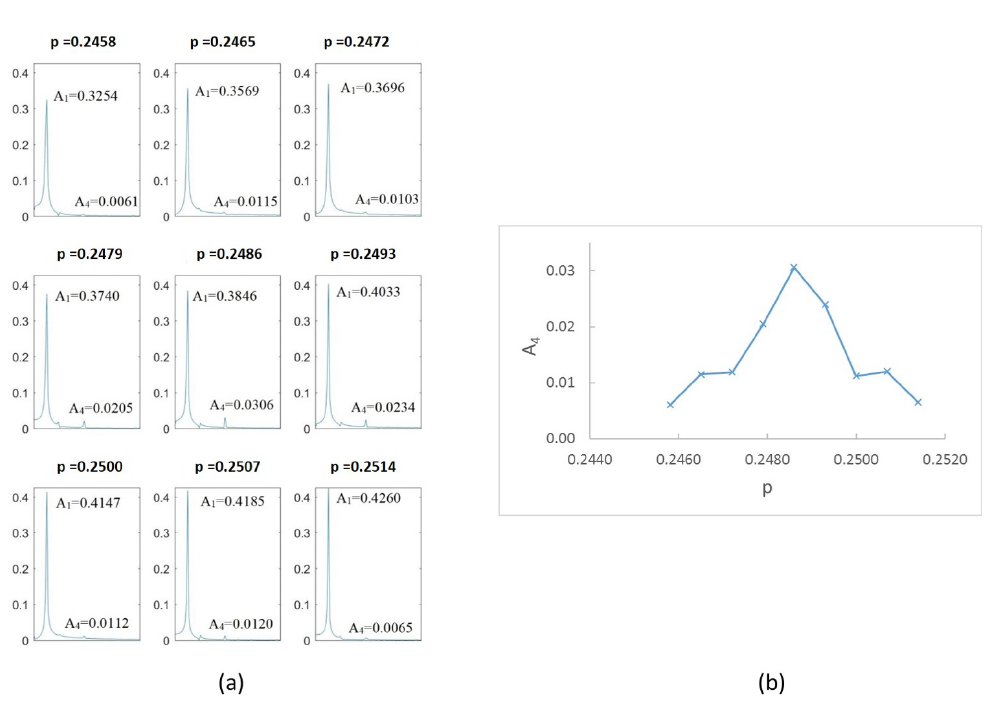
Ω c and ( b ) amplitude A 4 versus rotation speed for 4